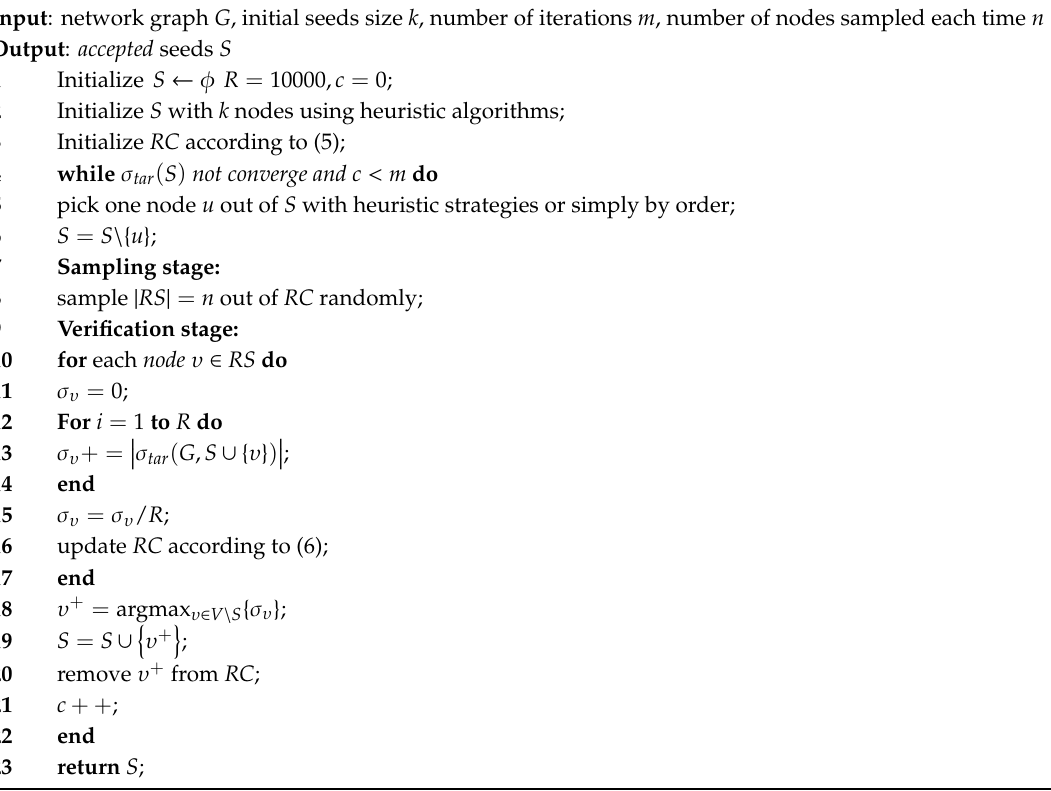
Algorithm 5: EG − SV ( G , k , m , n